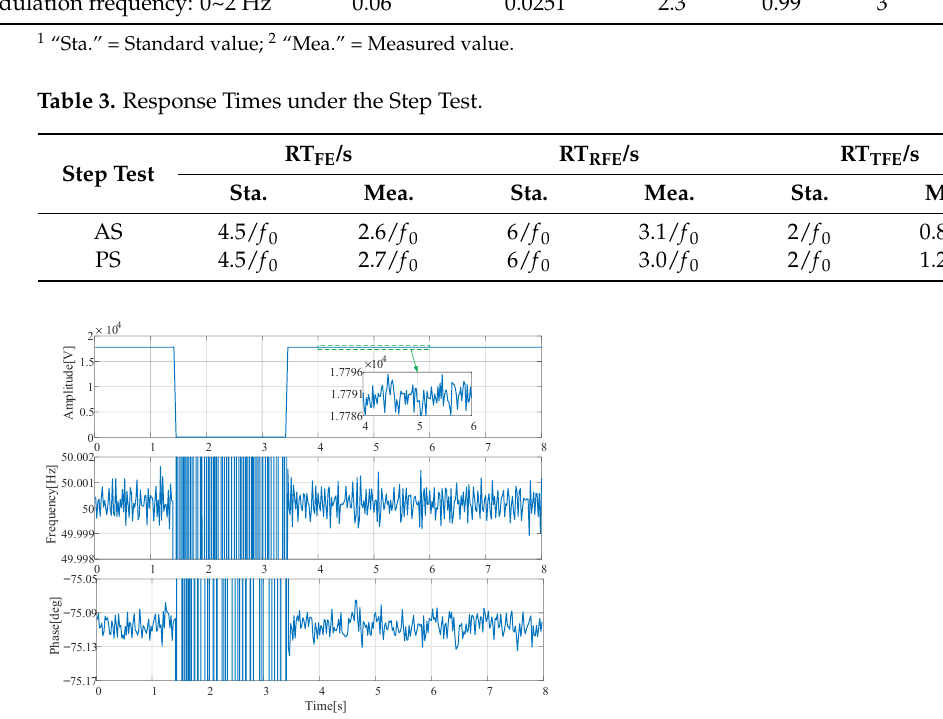
Table 2. Measurement Results of the PMU Prototype under Static and Dynamic Tests.